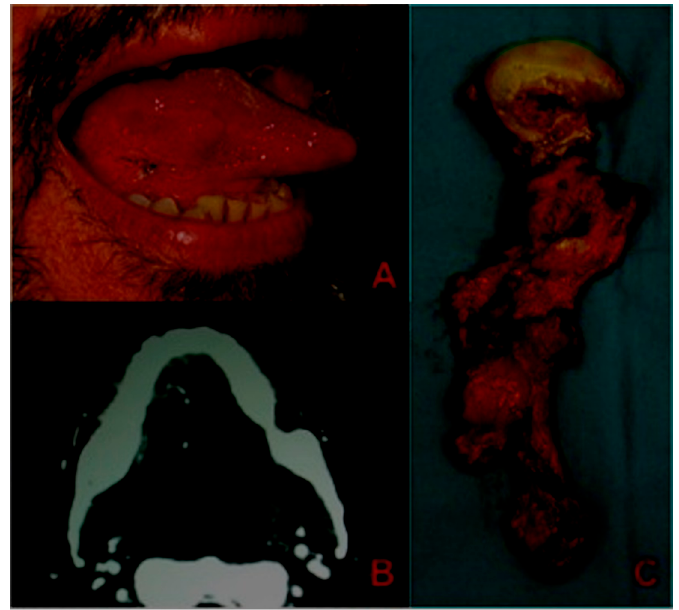
Figure 1. Case 1: A 67-years-old Caucasian male affected by a squamous cell carcinomas (SCC) of the middle third of the right tongue staged as pT2N0 who underwent partial glossectomy en-bloc with right modified radical neck dissection (MRND) using the “pull-through” technique; contemporary reconstruction was performed with anterolateral thigh (ALT). ( A ) Pre-operative intraoral view of the lesion; ( B ) pre-operative axial CT scan, with contrast showing a large lesion involving the right tongue; ( C ) intraoperative view of the specimen.